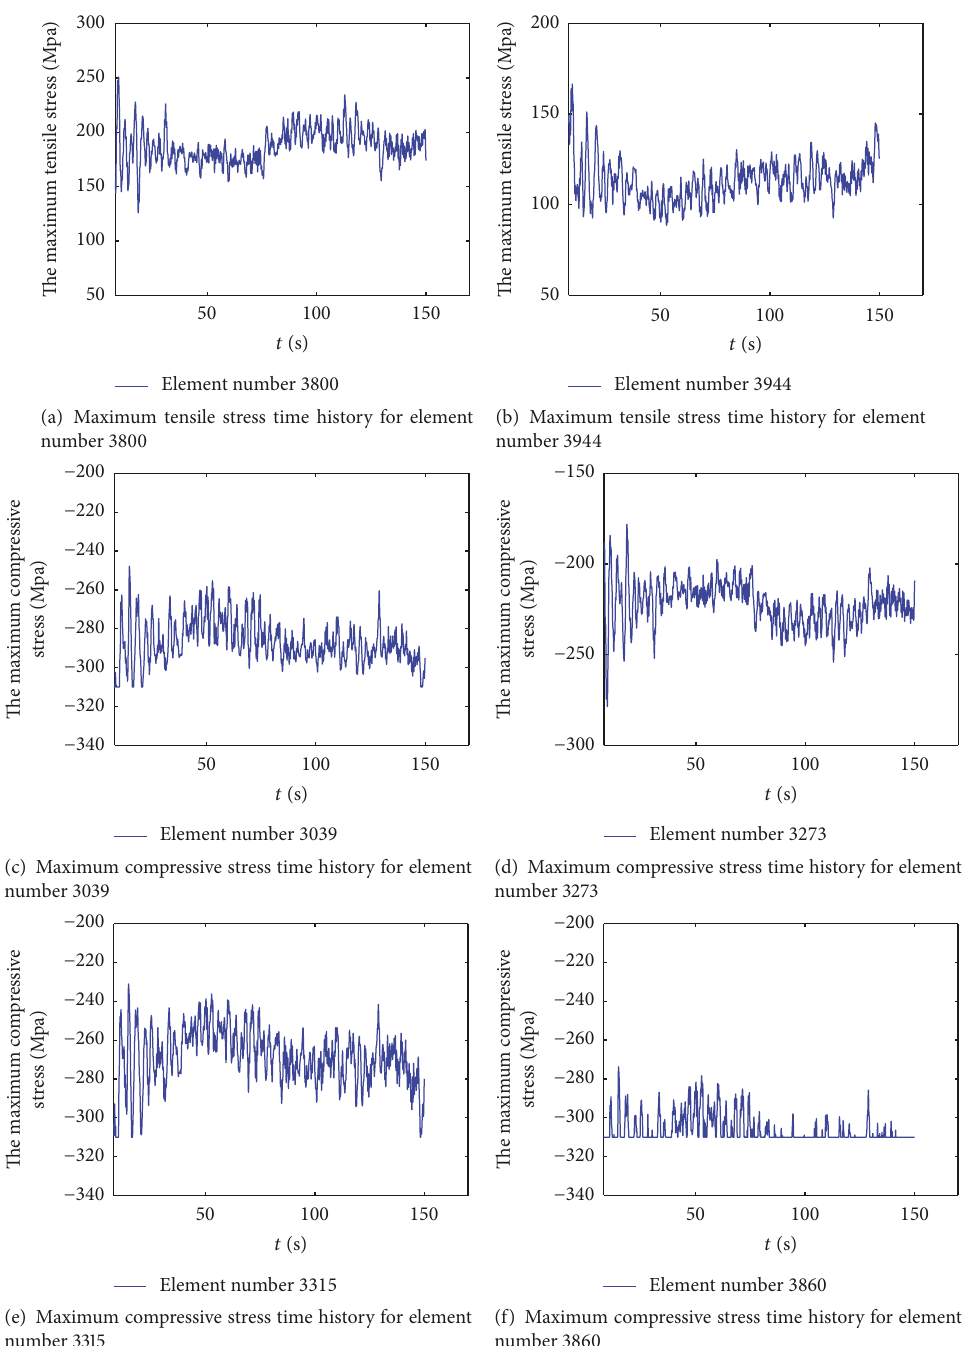
Figure 22: Stress time history response of the main members of the transmission tower in the tower-line system under the design wind speed ( 𝑈 10 = 25.3